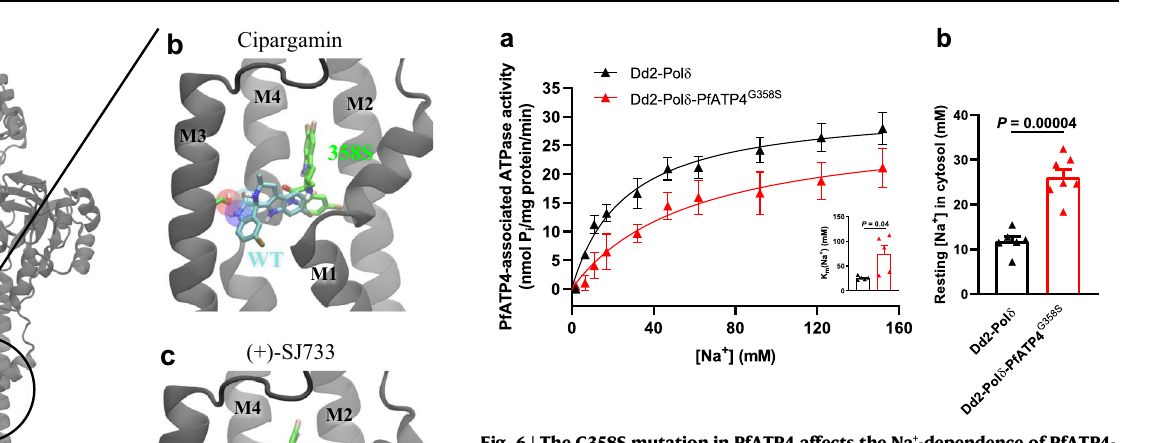
Fig. 6 | The G358S mutation in PfATP4 affects the Na + -dependence of PfATP4- associatedATPaseactivity.a Effectof[Na + ]onPfATP4-associatedATPaseactivity in membranes prepared from Dd2-Pol δ -PfATP4 G358S parasites (red triangles) and theirDd2-Pol δ parents(blacktriangles).Thedatashownarethemean(±SEM)from fi ve independent experiments, each performed on different days with different membrane preparations. The Michaelis – Menten equation (PfATP4-associated ATPase activity= V max × [Na + ]/([Na + ] + K m (Na + )))was fi tted to the data. The K m (Na + ) in the two lines is shown in the inset, with the symbolsshowing the K m (Na + ) values from each individual experiment, the bars showing the mean, and the error bars showingtheSEM.Atwo-tailedpaired t testwasusedtocomparethe K m (Na + )values obtained for the two lines. b Resting cytosolic [Na + ] in Dd2-Pol δ -PfATP4 G358S para- sites (red) and their Dd2-Pol δ parents (black). The measurements were performed with isolated trophozoite-stage parasites loaded with the Na + -sensitive dye SBFI, and suspended in pH 7.1 Physiological Saline Solution at 37°C. The bars show the mean + SEM obtained from six (Dd2-Pol δ ) or seven (Dd2-Pol δ -PfATP4 G358S ) inde- pendent experiments for eachline(performedondifferent days),and the symbols show the results obtained in individual experiments. The P value is from a two- tailedunpaired t test. P values ≤ 0.05indicatestatisticalsigni fi canceandareshown in bold. Source data are provided as a Source Data fi